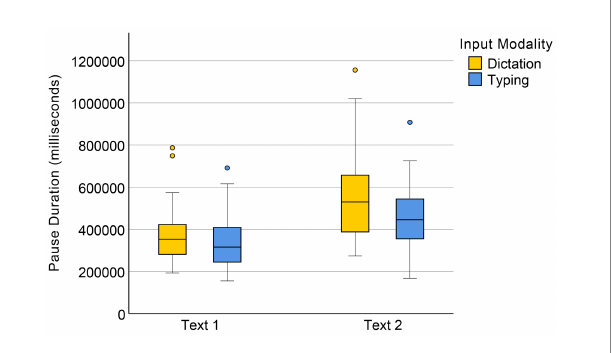
FIGURE 7 Duration of pauses in dictation and typing